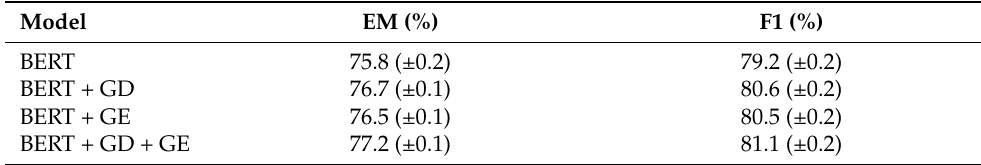
Table 3. Impact of various modules on the performance of the model.